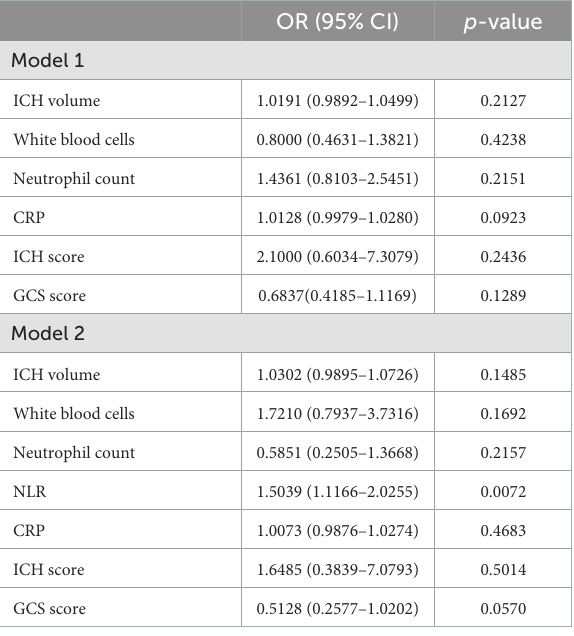
TABLE 5 Construction of predictive mathematical models for ICH